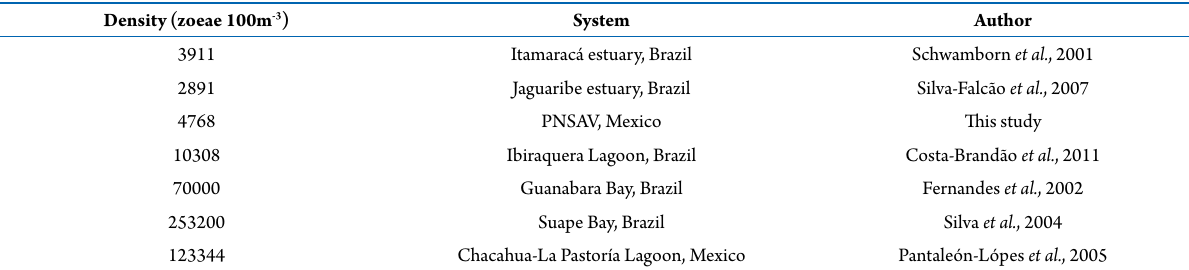
Table 9. Density of Brachyura zoea I 100 -3 in lagoons, bays and